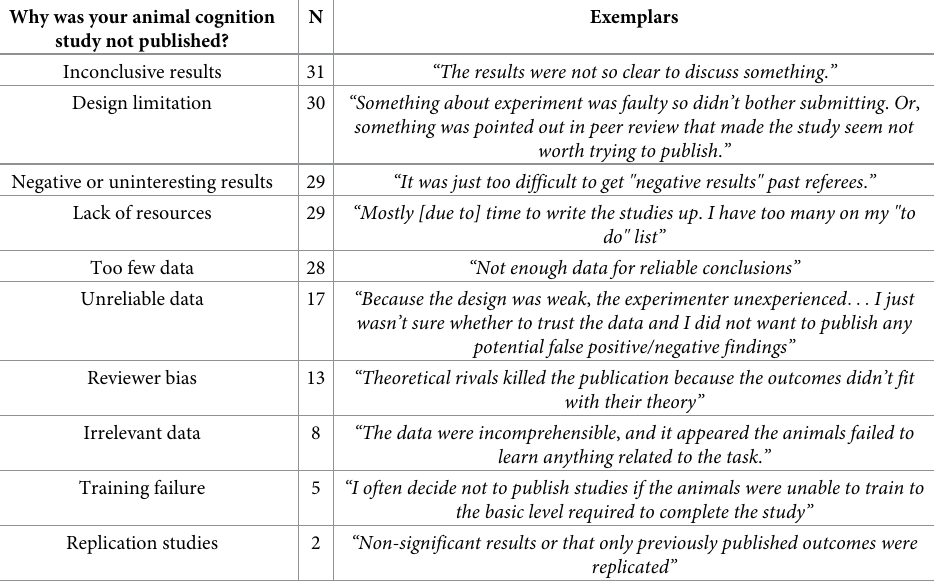
Table 4. Animal cognition researchers’ explanations for why some of their studies go